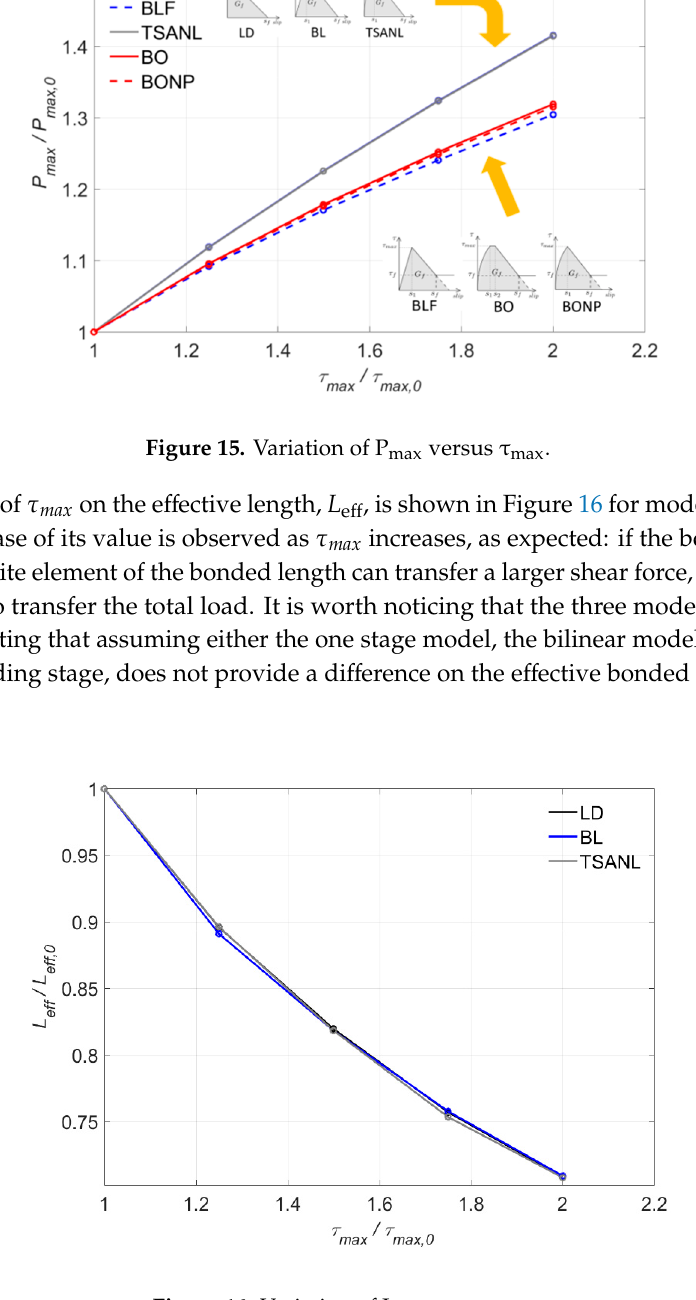
τ max e ff versus